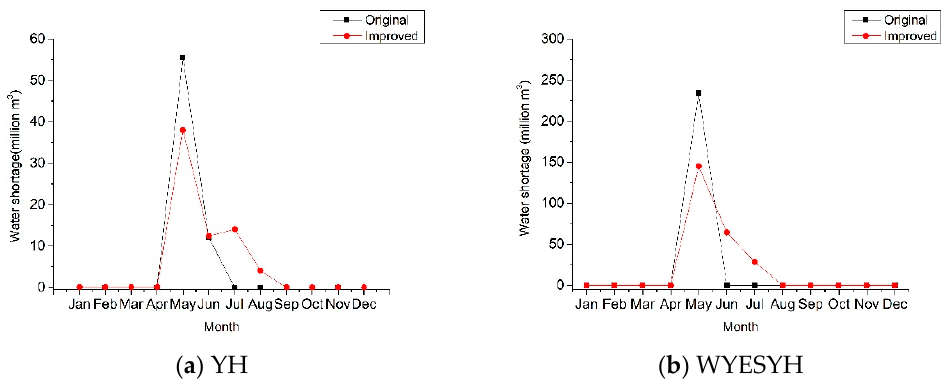
Figure 5. The difference in water shortage quantity before and after improvement under different precipitation frequencies.